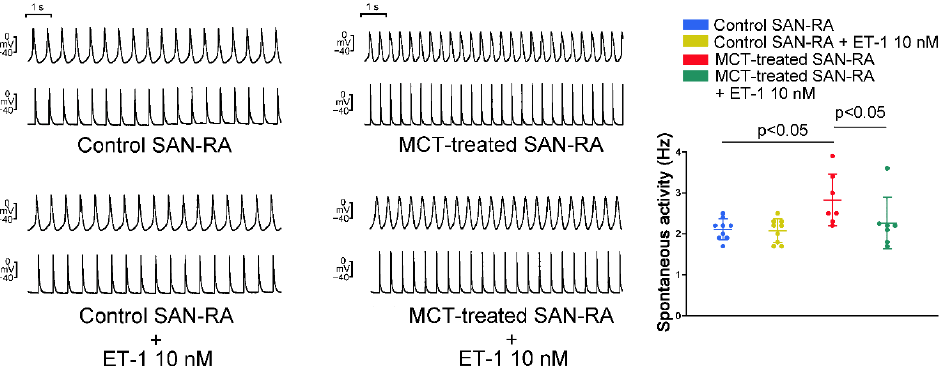
Figure 3. The spontaneous activity of sinoatrial node-right atrium (SAN–RA) preparations from control or monocrotaline (MCT)-treated rabbits and the effect of endothelin (ET)-1 on the spontaneous activity of sinoatrial node (SAN)–right atrium (RA) preparations from the control or monocrotaline (MCT)-treated rabbits. Representative tracings and average data of the AP morphology in SAN–RA preparations with or without ET-1 (10 nM) from the control (left panel, N = 7) or MCT-treated (right panel, N = 9) rabbits are shown.